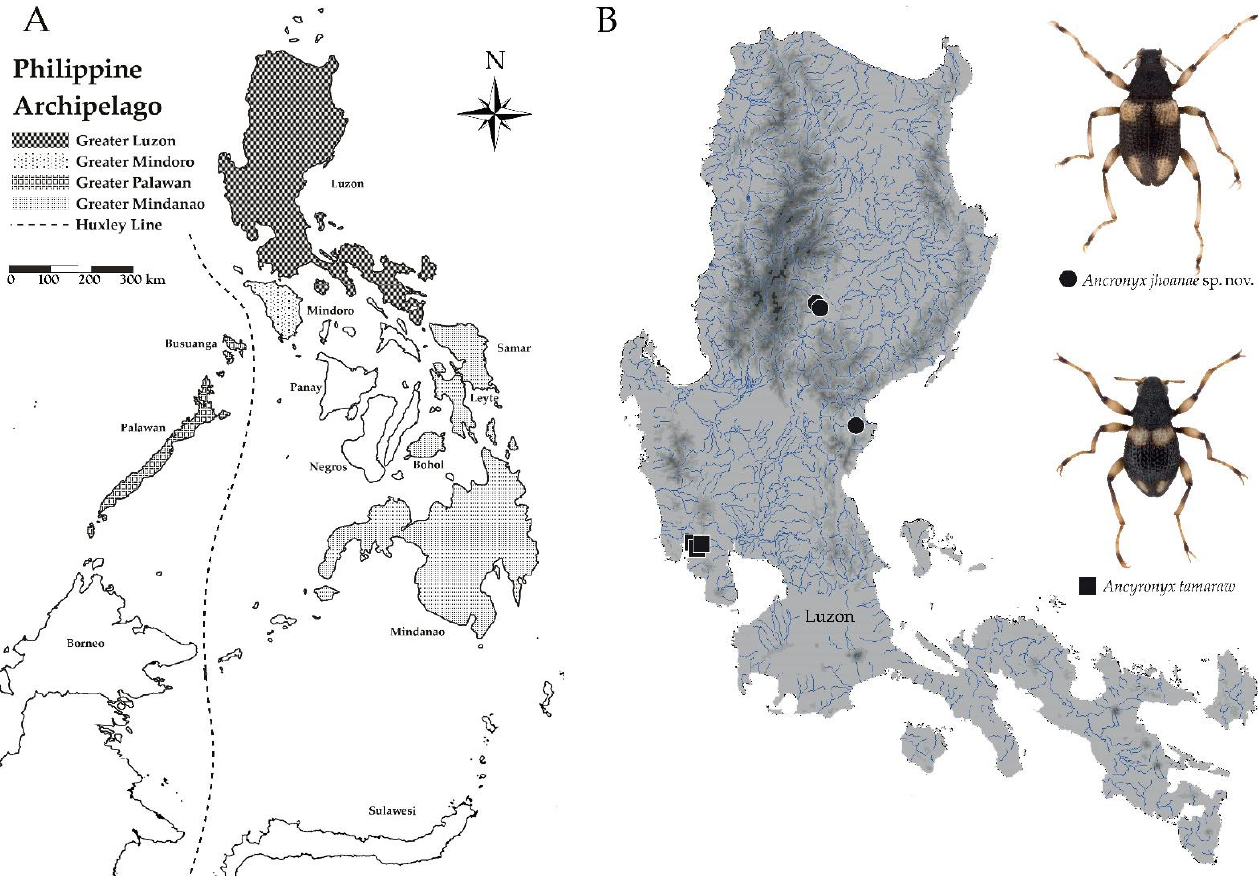
Figure 5. Maps with ( A ) major intra-Philippine biogeographical regions and ( B ) collection sites of Ancyronyx jhoanae sp. nov. and A. tamaraw Freitag, 2013 in Luzon. Molecular data suggest that the newly identified species is part of a lineage previ-